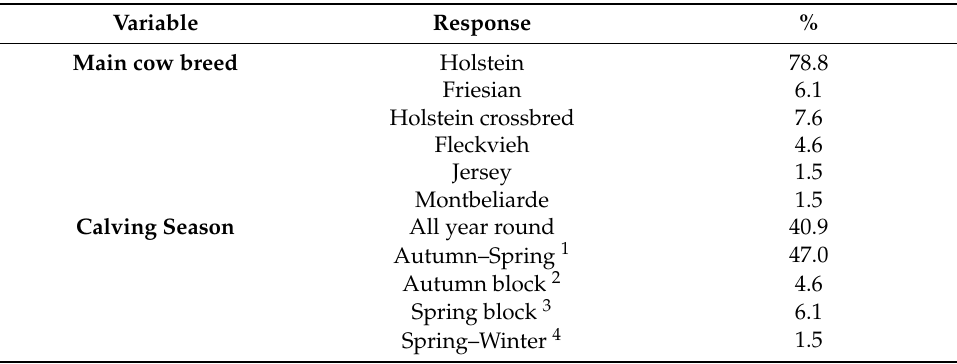
Table 1. Dairy herd demographic information of the 66 participating